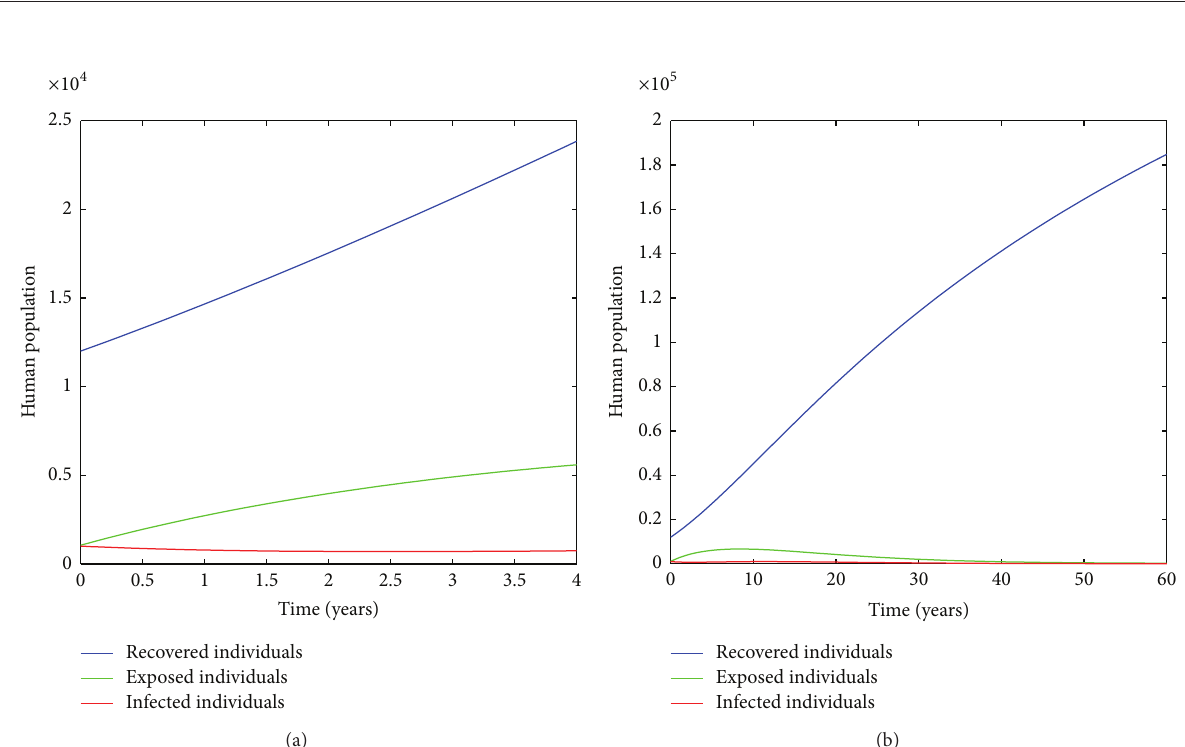
Figure 7: The dynamics of the exposed and infected individuals in the model with intervention strategies for R 𝑒 = 0.6922 .